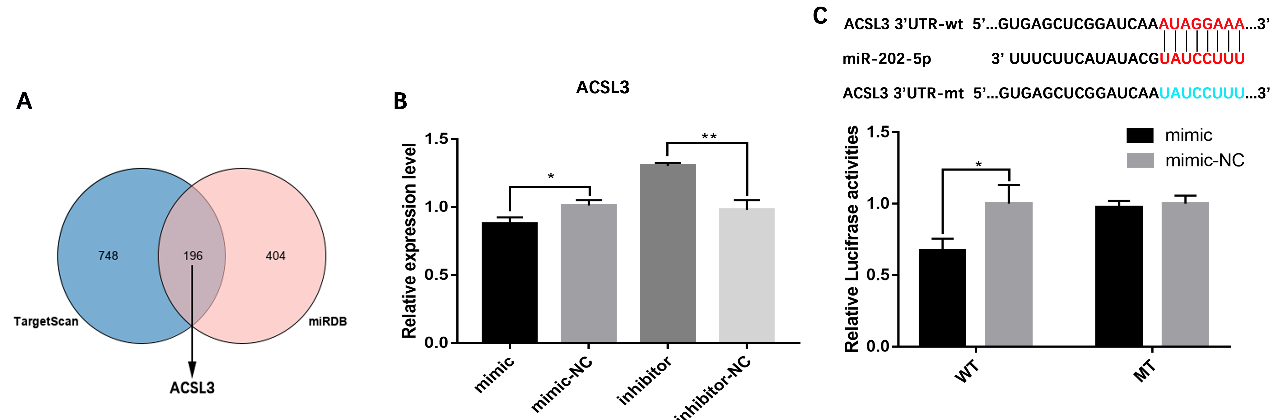
Figure 4. Identification of the targeting relationship between miR-202-5p and ACSL3. ( A ) predicted target genes from TargetScan and miRDB, and identification of candidate miR-202-5p target genes, ( B ) effect of miR-202-5p on the expression level of ACSL3 in GCs, and ( C ) experimental validation of the binding site of miR-202-5p in the 3 ′ -UTR of ACSL3 by a luciferase reporter gene assay. wt, wild-type; mt, mutant-type. * p < 0.05, ** p < 0.01.